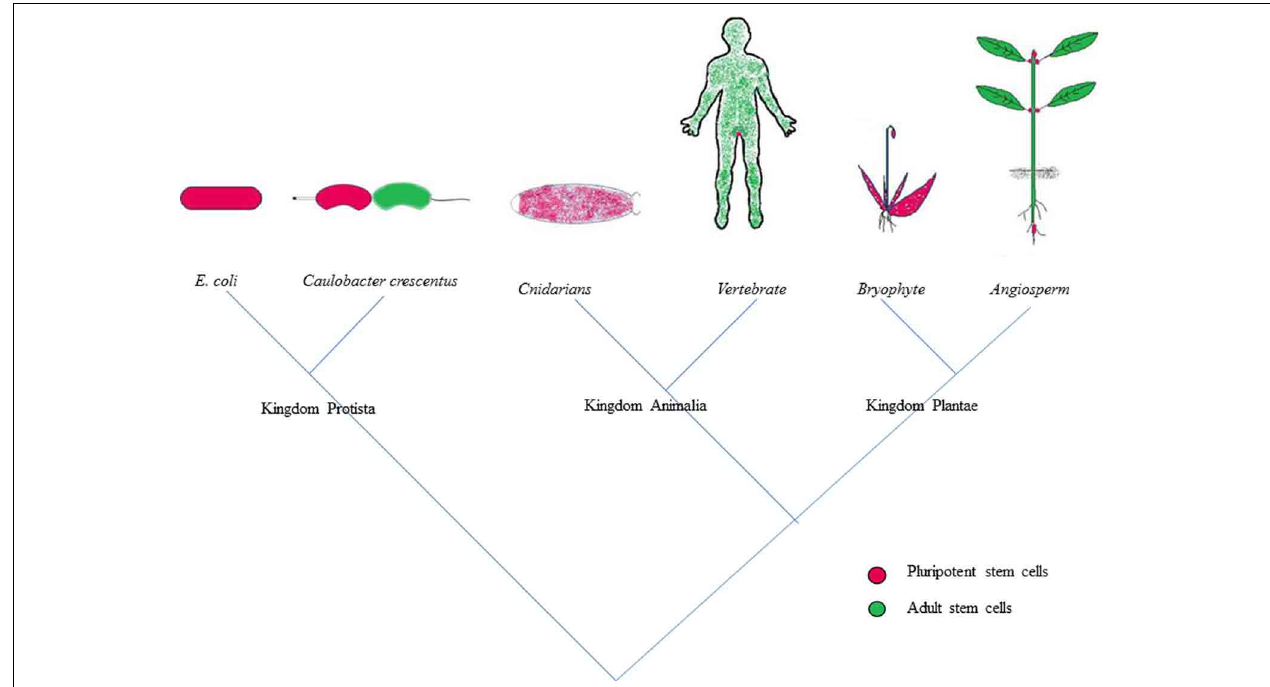
FIGURE 1 | Tree of regeneration; depicting the competence for regeneration across the kingdoms of life. Adult stem cells are partly differentiated cells that can give rise to a limited number of cell types while the pluripotent stem cells are competent to give rise to all